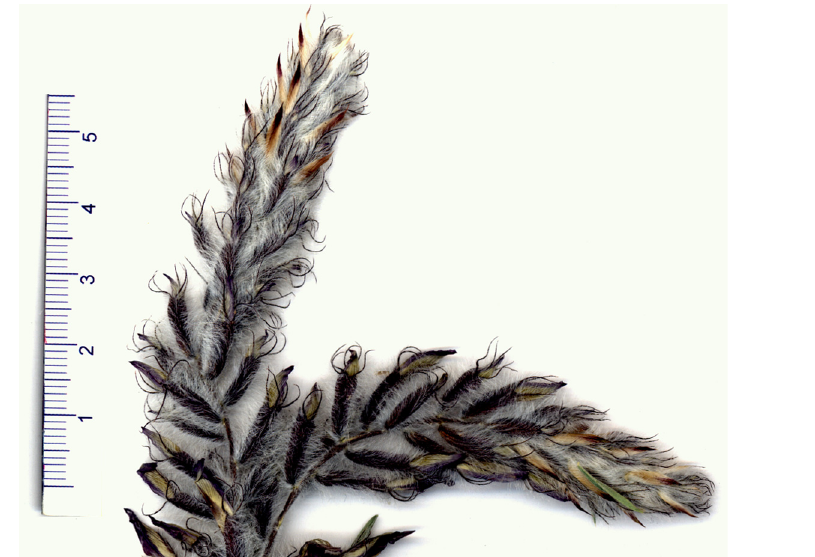
Fig 6. Close up of the